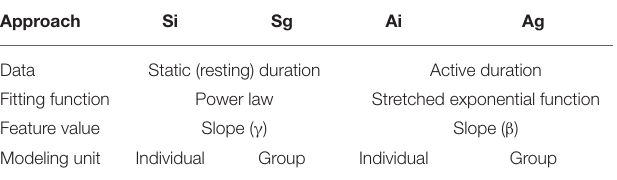
TABLE 1 | Four approaches as